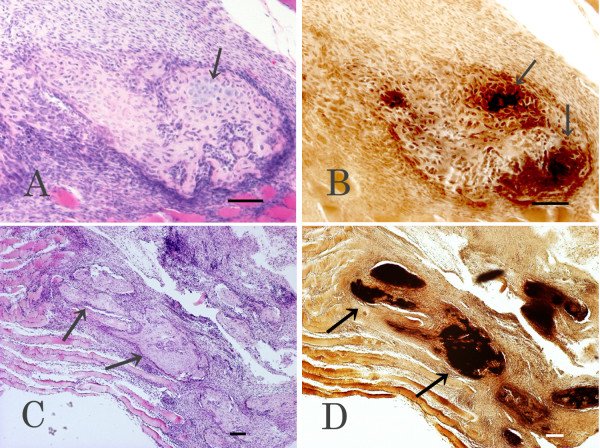
Histological analyses 10 days after in vivo electroporation. Histological examinations were carried out 10 days after electroporation with pCAGGS and pCAGGS-BMP-2 or pCAGGS-BMP-2 and pCAGGS-BMP-7. A section stained with HE from muscle electroporated with pCAGGS and pCAGGS-BMP-2 (A) contained cartilage (arrow). A serial section stained with von Kossa showing partially calcified areas (B, arrows). A HE-stained section of muscle electroporated with pCAGGS-BMP-2 and pCAGGS-BMP-7 showing ectopic bone (C, arrows). The calcified areas that stained with von Kossa (D, arrows) in the pCAGGS-BMP-2 and pCAGGS-BMP-7-transfected muscles were much wider and more strongly stained than in the BMP-2-transfected sections (B). Scale bar: 100 μm.